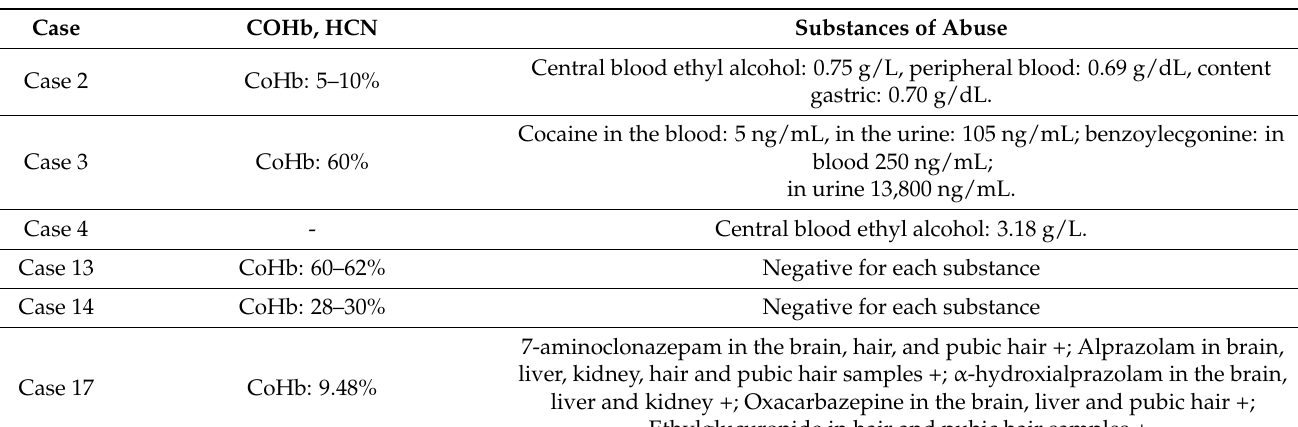
Figure 9. ( A ) Predominantly within the bronchial structures and terminal bronchioles but, also, rather sporadically, in the alveoli, incongruent and blackish-colored particles, sometimes confluent. ( B ) The trachea preparation shows, endo-luminally, the presence of incongruent blackish material, probably sooty and adherent to the epithelium. ( C ) The proximal part of the larynx shows heat epithelial changes well evidenced by the antibody reaction to HSP 27. ( D ) A massive pulmonary adipose embolism demonstrating the viability of the lesion; death occurred because of the burning of the body. ( E ) Peeling of the epidermal layer with the cells arranged as a «palisade» with some sub-epidermal gaps. The underlying connective tissue shows destruction of the nuclear chromatin, as well as phenomena of coagulative necrosis. ( F ) Cerebral vessel with lumen completely occupied by conglutinated blood material due to the action of heat and detachment of the parietal layers. Table 6. Toxicological exams were carried out in 45/82 cases of burned bodies. The COHb and HCN concentration were tested in central blood, while the research of substance of abuse was carried out in blood, urine, hair, and fragments of tissues (brain, kidney, and